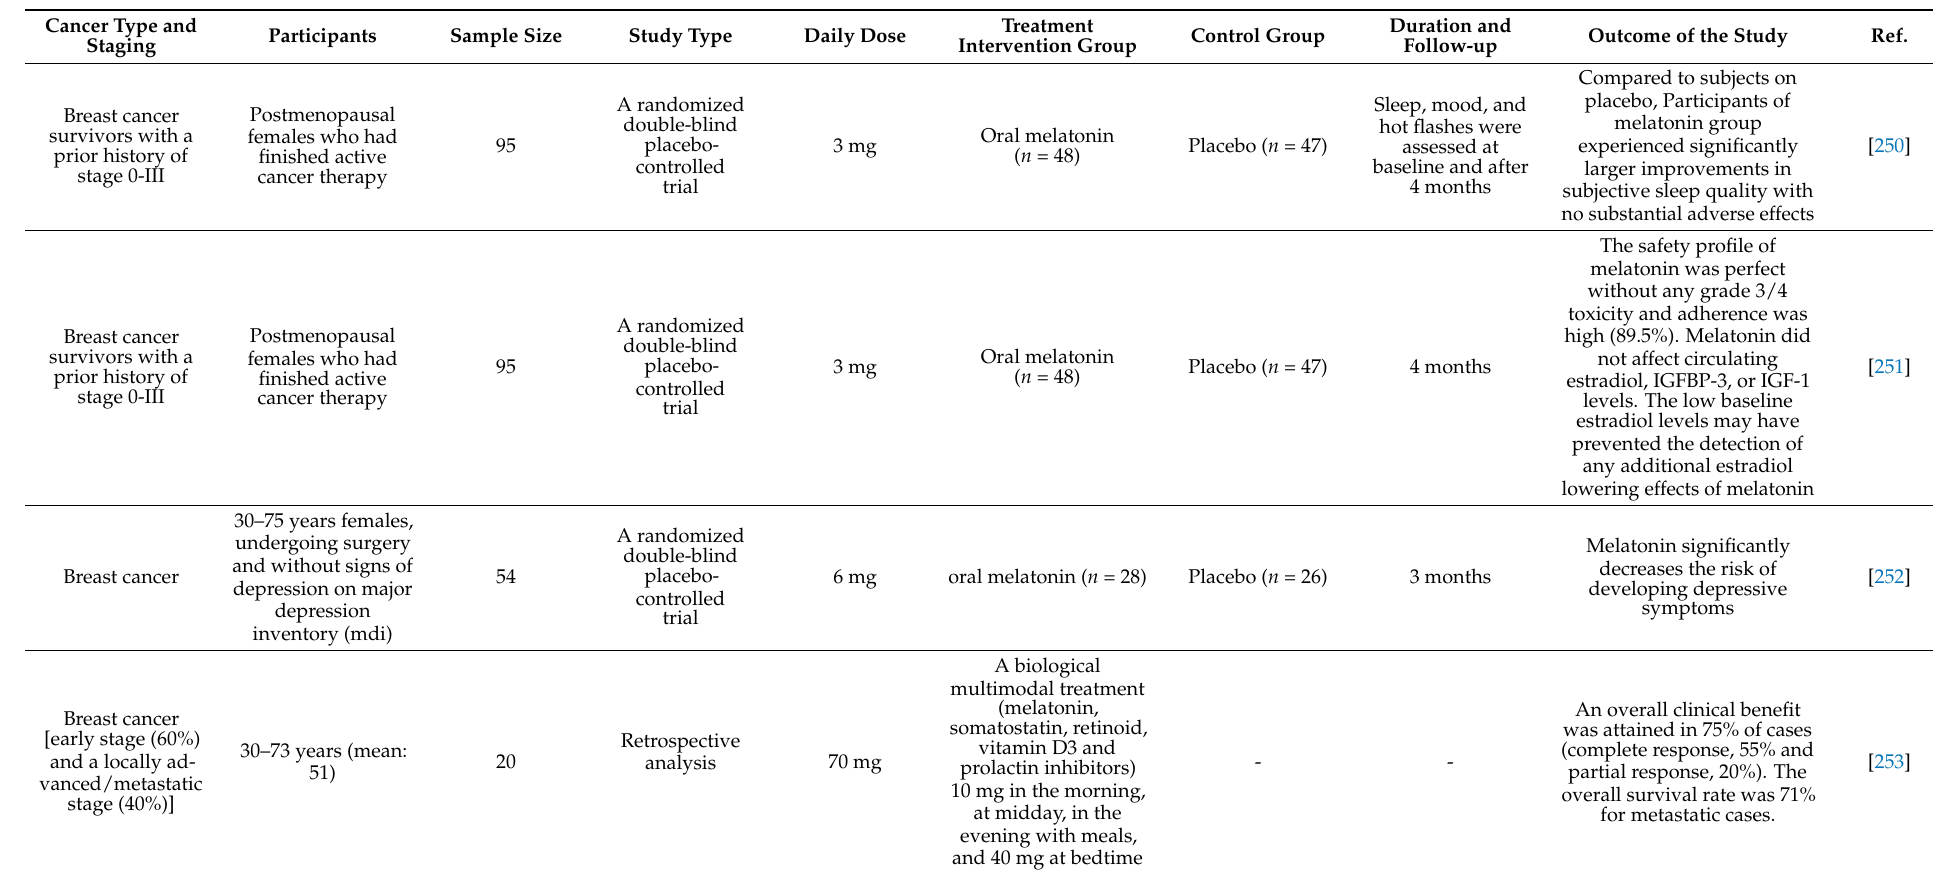
Table 3. Published clinical human studies evaluating the effects of melatonin on cancer patients as reported in the last 10